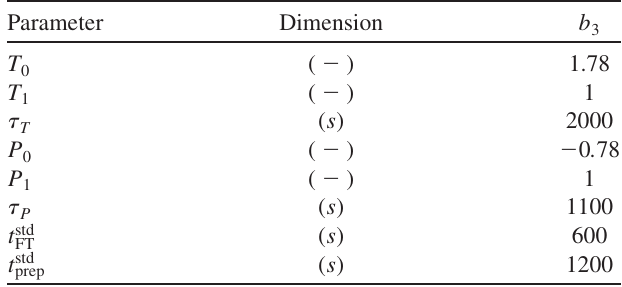
TABLE III. Parameters of Eq. (5) based on beam-based mea- surements.